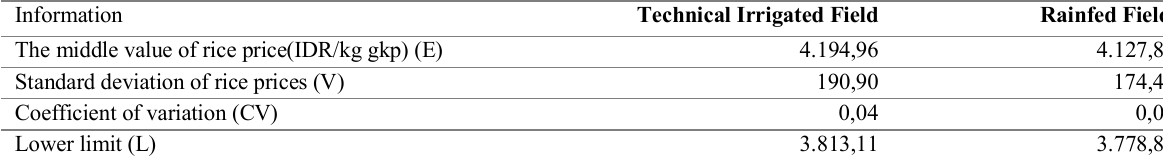
Table 2: Price Risk for Rice Farming on Technical Irrigated Rice Field